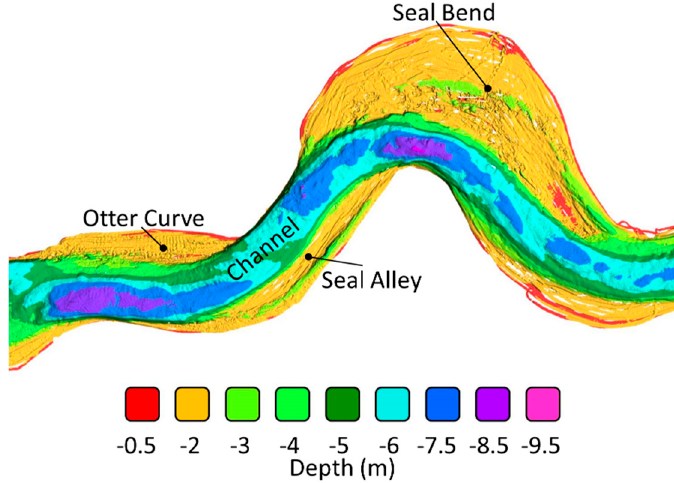
Figure 3. Bathymetry of Elkhorn Slough at the time of image collection corresponding to high slack tide. Eelgrass beds at Seal Bend, Otter Curve, and Oyster Alley occur in the shallower depths ~2 m. A deep channel runs through the center of Elkhorn Slough with higher current flow.